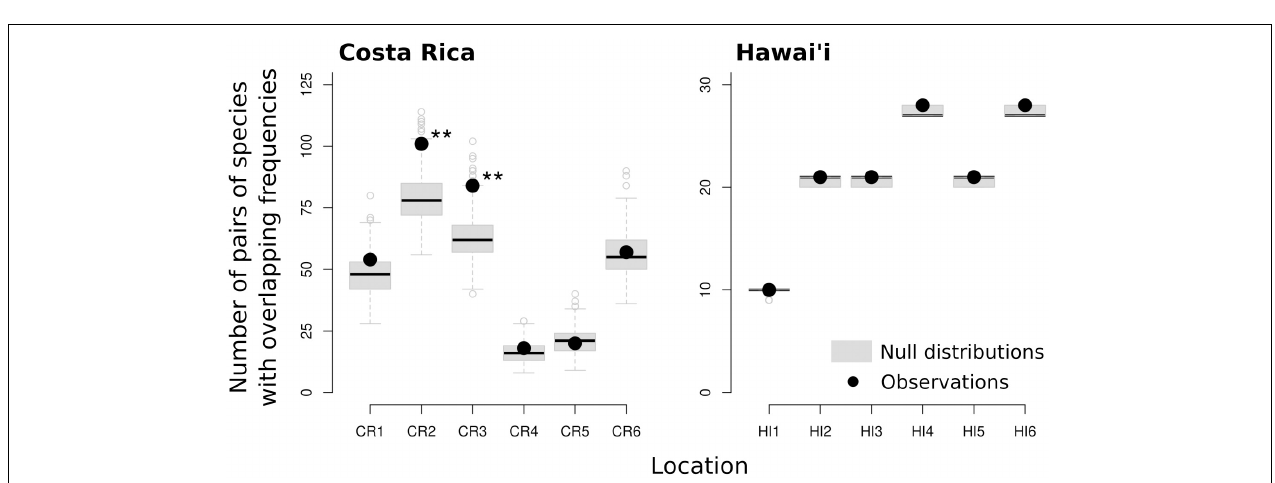
FIGURE 4 | Comparison of observed and expected number of heterospecific pairs of vocalizations with overlapping vocalization times and frequencies in each location (significance “***” α = 0.001, “**” α = 0.01). The null distributions were generated using 500 randomizations of the beginning of vocalizations (keeping number, length and spectral characteristics